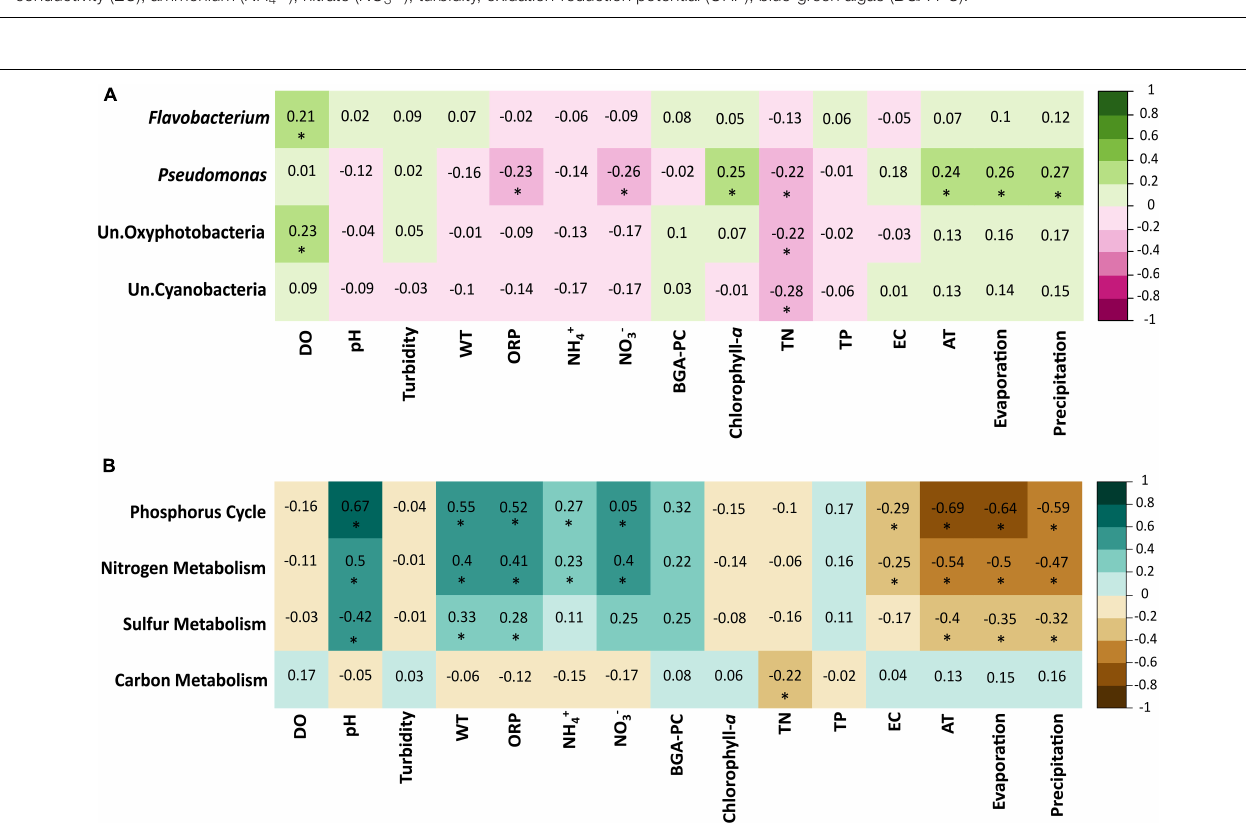
FIGURE 7 | (A) Mantel tests based on Spearman correlations between most abundant taxa of bacteria and physicochemical factors. (B) Biogeochemical metabolism and physicochemical variables. Significant correlations ( p < 0.05) are marked with an asterisk. Water temperature (WT), dissolved oxygen (DO), pH, electrical conductivity (EC), ammonium (NH 4 + ), nitrate (NO 3 − ), turbidity, oxidation-reduction potential (ORP), blue-green algae (BGA-PC), and air temperature (AT).